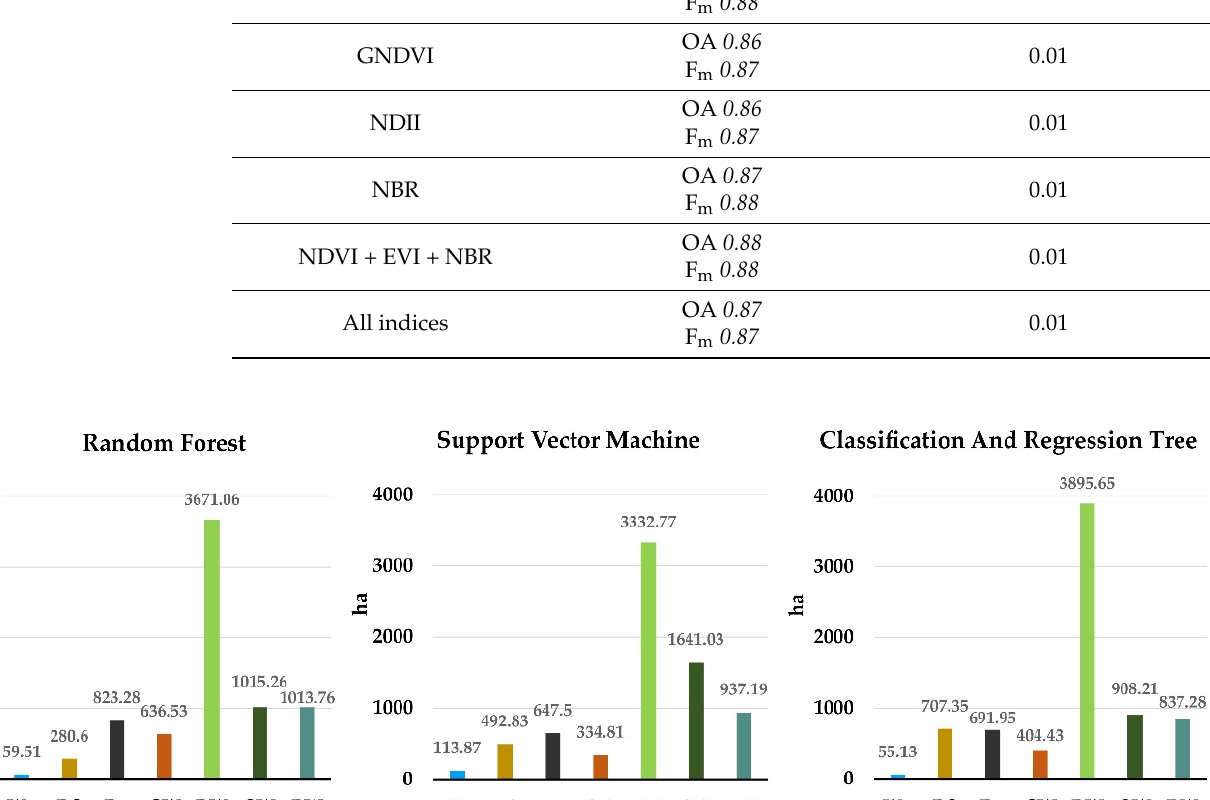
classification and regression tree) and for each adopted land ‐ cover (LC) class (Wa: water; BS: bare soil; Ro: roads; CW: